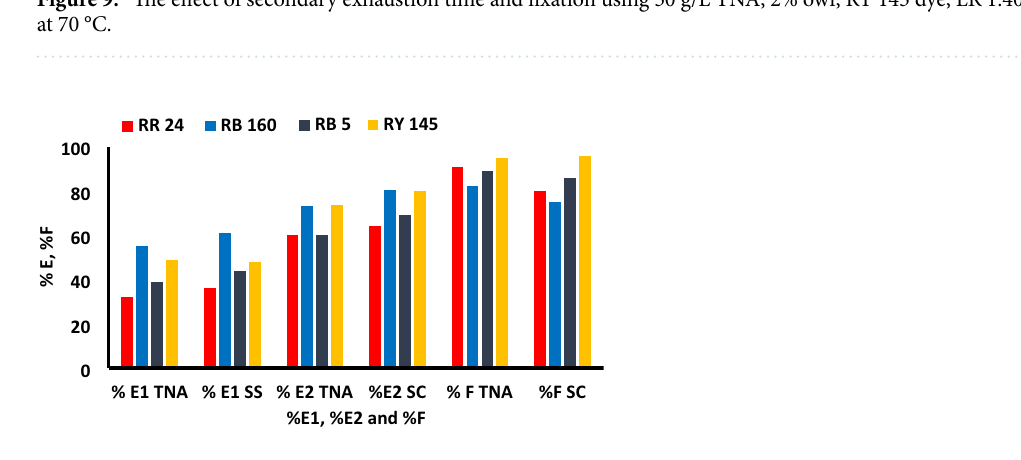
Figure 10. Primary (%E1), secondary (%E2) exhaustion and fixation (%F) for different reactive dyes using 50 g/L TNA, 2% owf, LR 1:40 for 60 min dyeing time at 60, 70, 80 °C for RB5, RY 145, RR 24 and RB 160, respectively and compared with conventional dyeing with 50 g/L SS and 20 g/L